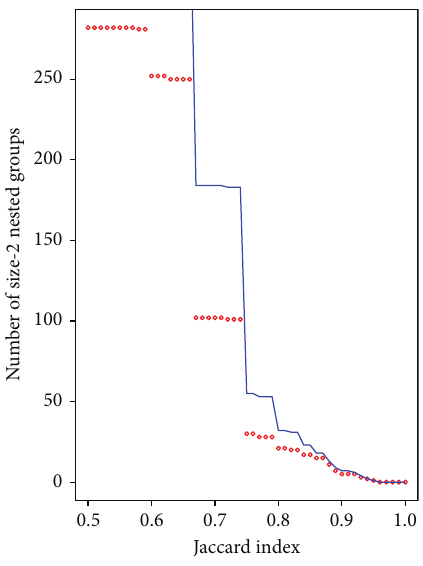
Figure 4: Number of size-2 nested groups (one maximal complex and one subcomplex) for a given Jaccard index. The red line represents the whole subset while the blue dots represent just the number of cases coming from more than one paper or database. High Jaccard seems to correlate with information coming from multiple sources, suggesting that high Jaccard in nested groups may come from data integration problems.